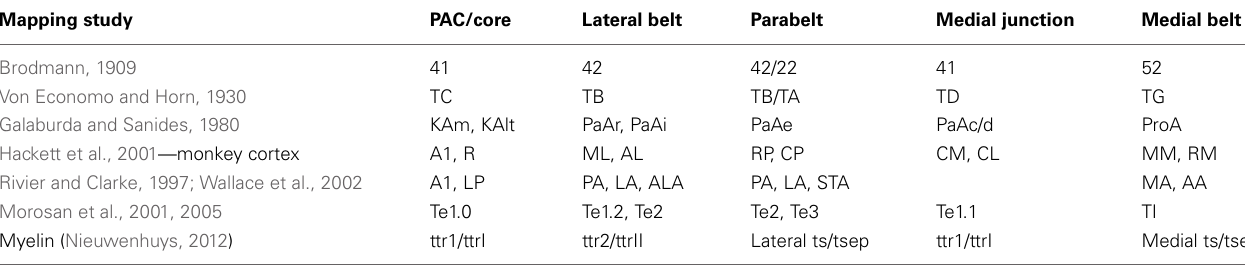
Table 1 | Comparison of human cytoarchitectonics and primate